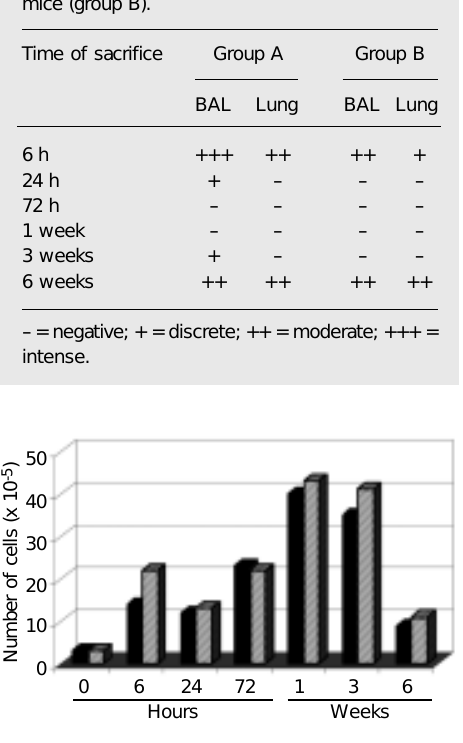
Figure 2. Evaluation of the func- tional status of macrophages present in the bronchoalveolar lavage of thalidomide-treated (filled columns) and untreated (open columns) mice by the cell spreading technique. Data are reported as medians of percent. + P < 0.05 compared to the un- treated group (Kruskal-Wallis test). *P < 0.05 compared to the untreated infected group (Kruskal-Wallis test).